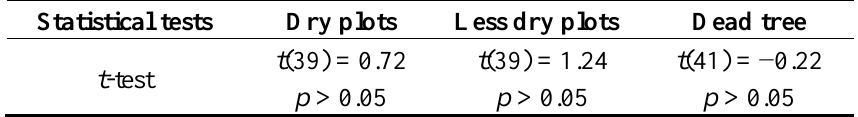
Table 4. Results of model testing for biomass equations (Figures 9a,b and 10) in dry and less dry